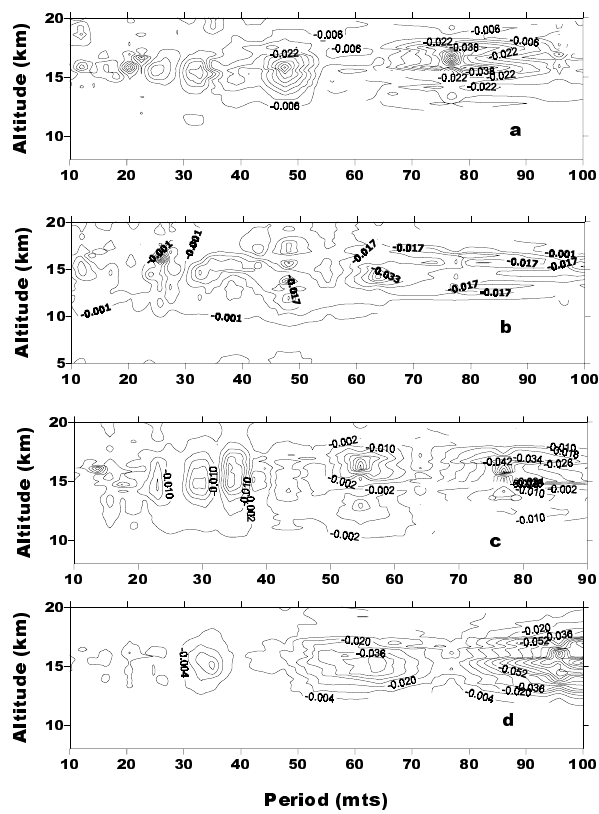
Fig. 16. The variation in the strength of zonal momentum flux with wave period and altitude for (a) 25, (b) 26, (c) 27 and (d) 28 August 1999. Contour interval is 0.008(m/s) 2